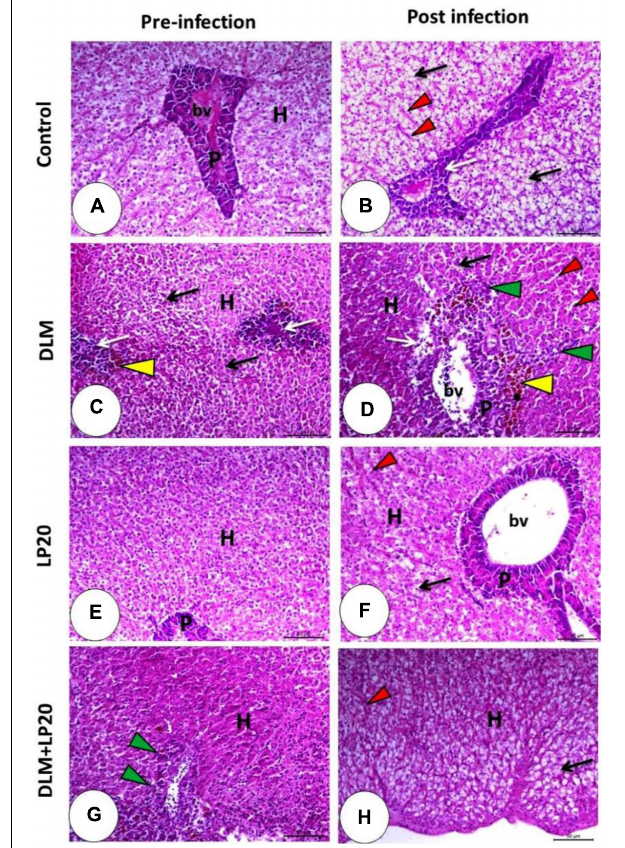
FIGURE 8 | Histomicrograph of the liver of Nile tilapia subjected to four treatments (control, DLM, LP20, and DLM + LP20) before (A,C,E,G) and after (B,D,F,H) infection. Panel (A) shows intact hepatocytes that arranged in cords separated by blood sinusoids (H), and the pancreatic acini appeared normal with a basophilic basal part and eosinophilic apical part (P). Panel (B) shows fatty degeneration of hepatocytes, congested blood sinusoids (red arrowhead), and degenerated pancreatic cells (white arrow). The toxic effect of DLM (C) causes degeneration of hepatocytes with pyknotic nuclei (black arrow), degenerated pancreatic cells (white arrow), and melanomacrophages (yellow arrowhead). The DLM post-infected group shows degeneration of hepatic (black arrow) and pancreatic (white arrow) cells, dilated blood sinusoids (red arrowhead), melanomacrophage center (yellow arrowhead), and leukocytic infiltration (green arrowhead). LP20 improves the normal appearance of the hepatopancreas (E) , while post-infection decreases histopathological deviation except slight degeneration of hepatocytes (black arrow). In panel (G,H) , the hepatopancreas retains its normal structure in either the hepatic (H) or pancreatic part (P) with immune cell infiltration (green arrowhead) before infection and slight fatty degeneration (black arrow) post infection. Stain H&E. Bar = 100 µ